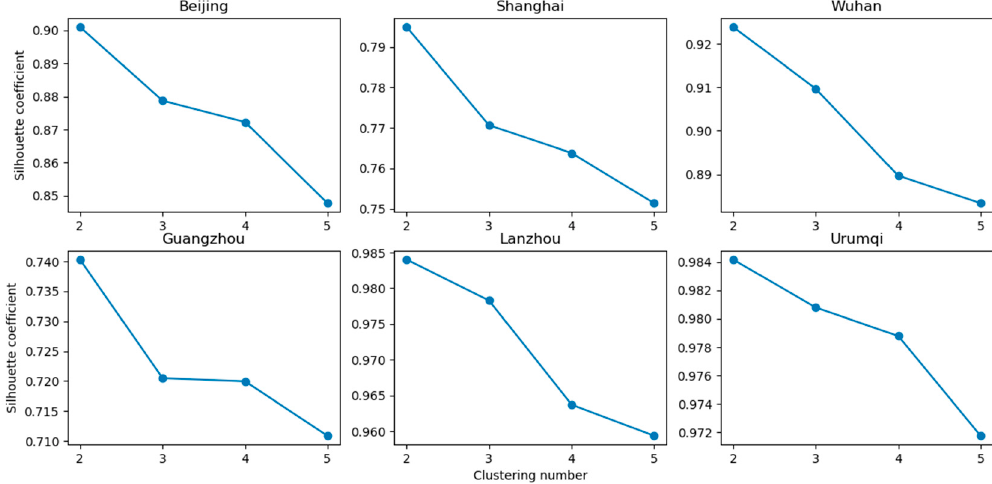
Figure 3. Average silhouette coefficient versus number of clusters.